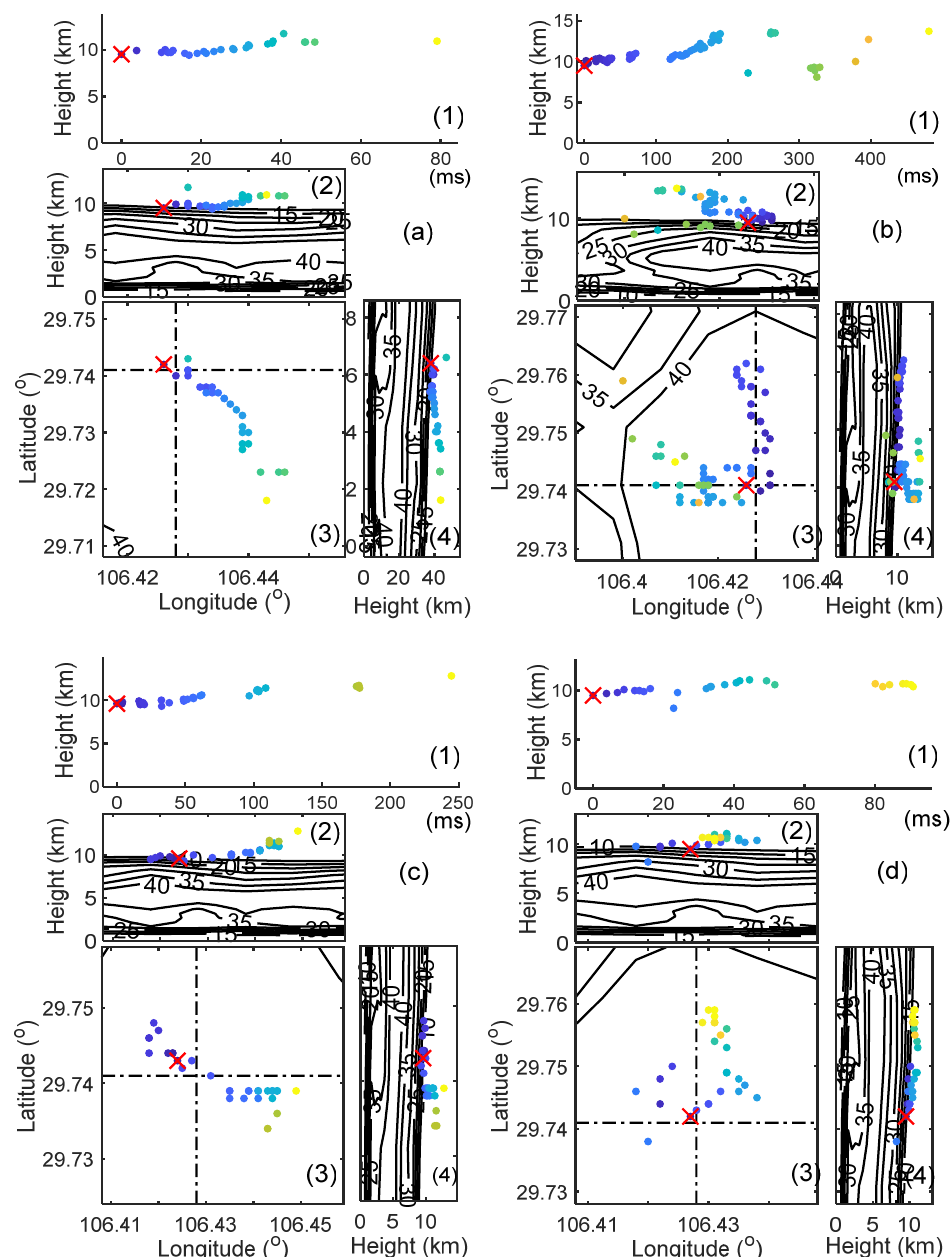
Figure 6. The 3D distribution of the channels of the lightning flashes initiated in the SD grid in the left-hand part of Figure 5a. The flashes in ( a – d ) were initiated at 17:40:34.443, 17:41:11.326, 17:41:31.617, and 17:42:05.762 CST, respectively. (1) illustrates the altitude evolution of VHF radiation sources with time; (2) and (4) give the distributions of reflectivity and the altitudes of VHF radiation sources in the vertical sections along the dot-dashed lines in (3); (3) shows the composite reflectivity and the horizontal projections of the VHF radiation sources. The contours in (2), (3), and (4) show the distribution of reflectivity (unit: dBZ). The colored dots illustrate the locations of VHF radiation sources and the colors represent their time differences relative to the first in ms. The red X indicates the location of the first VHF radiation source.